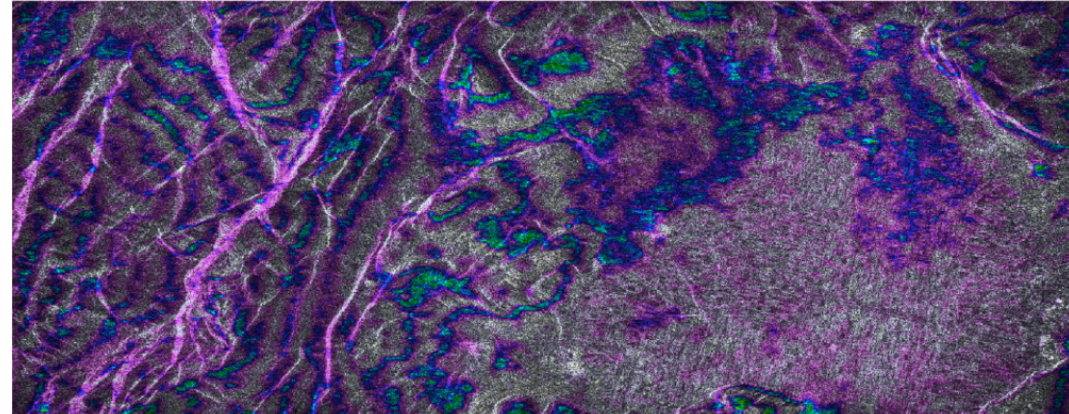
Figure 13. B-SAR, 5 looks, slope corrected interferometric image obtained by B.SAR focusing algorithm with superimposed the intensity image. Caramanico site, Fucino Valley,